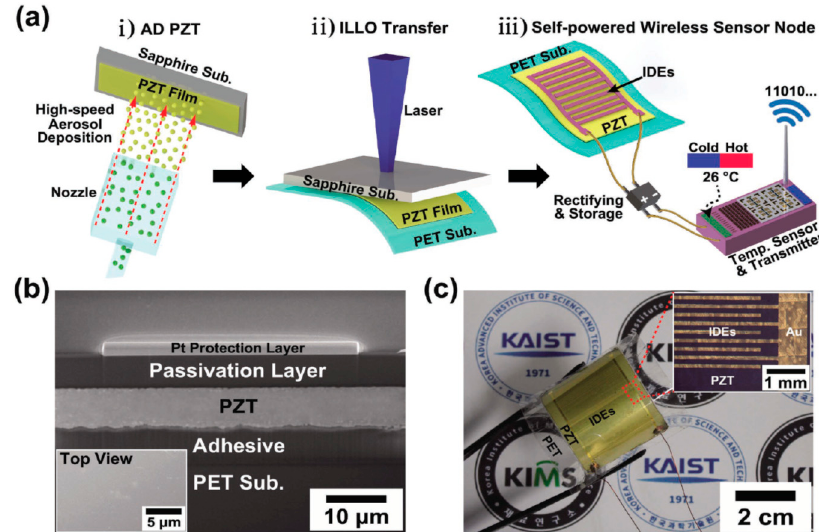
Figure 25. ( a ) Schematic of the fabrication of the flexible AD-PZT energy harvester enabled by inorganic-based laser lift-off (ILLO). ( b ) Cross-sectional SEM image of the PZT thick film on a polyethylene terephthalate (PET) substrate. ( c ) Optical image of the flexible PZT harvester. The inset shows the top-view of optical microscope image of metal IDE patterns on the PZT [69]. © Copyright 2016, Adv. Energy Mater.